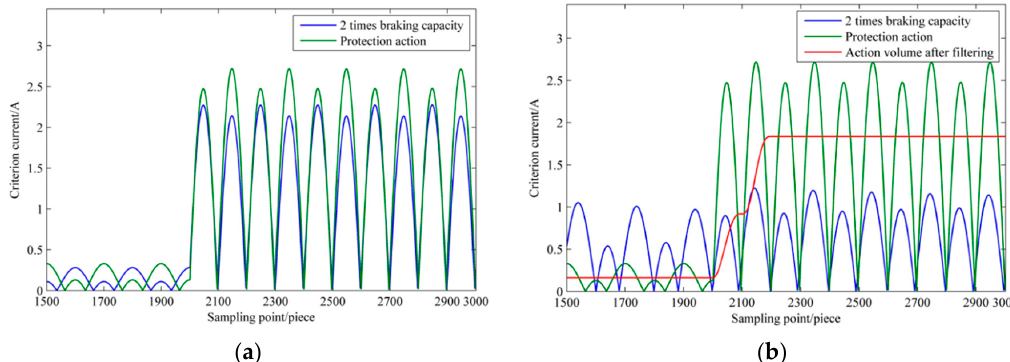
Figure 6. Comparison of fault braking current between traditional protection and new protection. ( a ) Stability comparison. ( b ) Amplitude deviations.